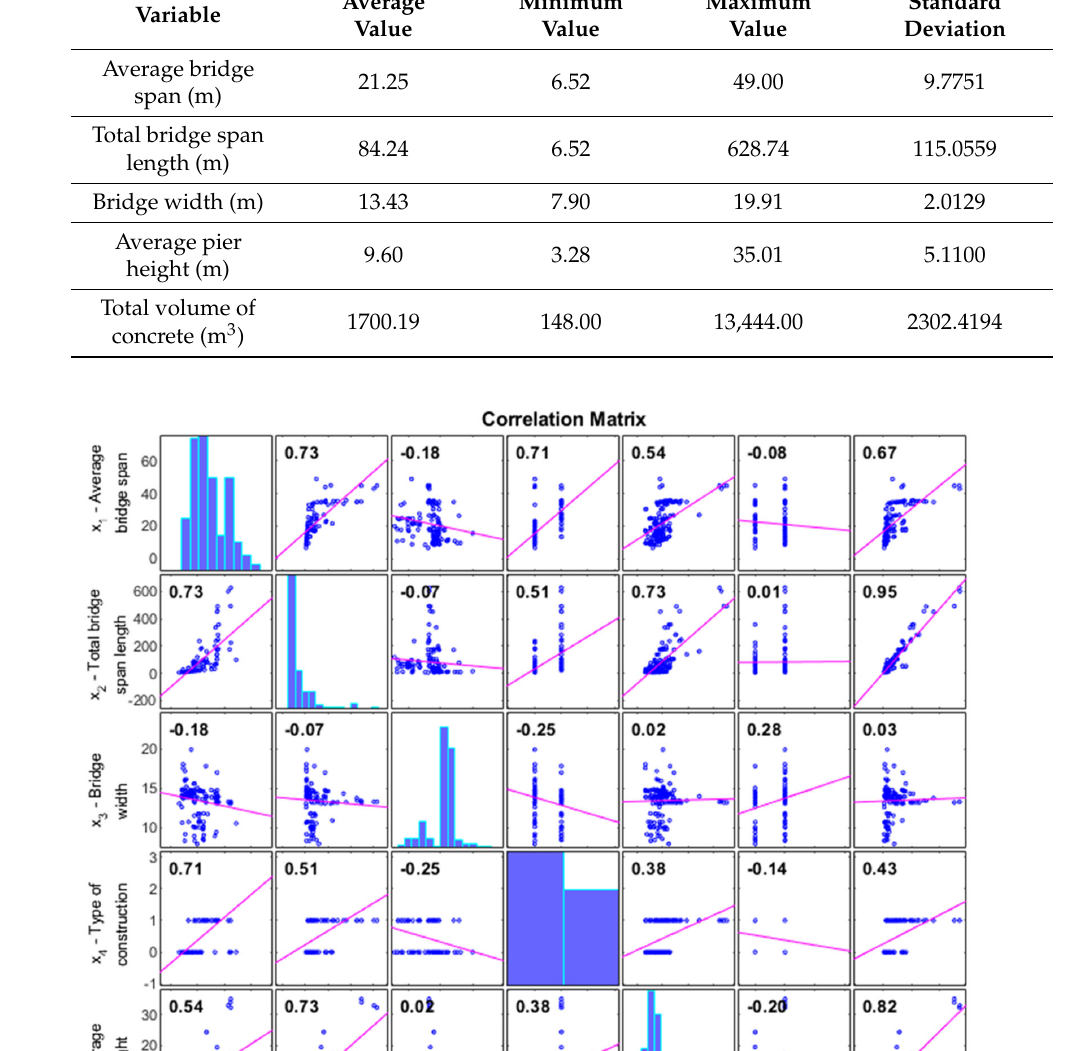
Table 1. Mean, minimum, and maximum values of variables in model.